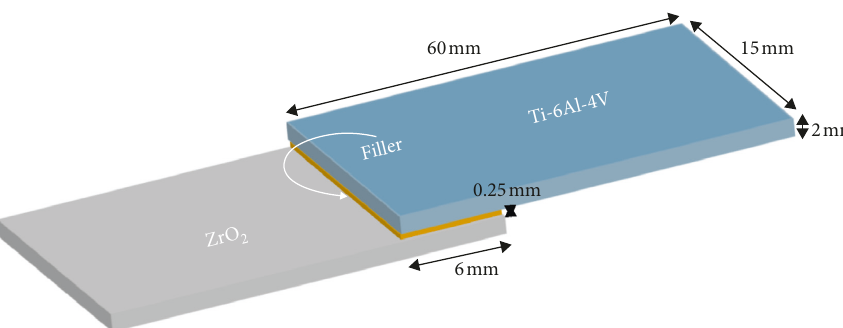
Figure 2: Schematic diagram for brazed joint fabrication.